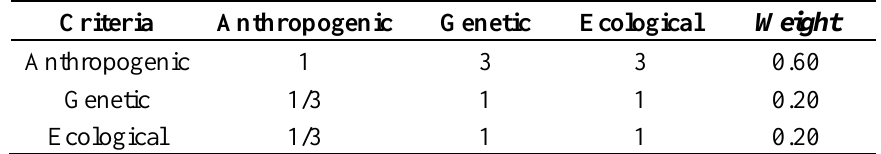
Table 2. Pairwise comparison matrix and relative weights of the criteria used to estimate the degree of risk of the populations of Pseudotsuga menziesii in central Mexico †